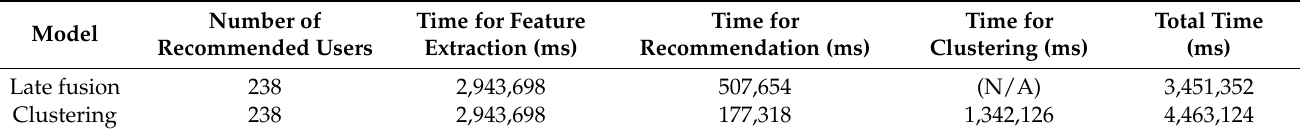
Table 2. The comparison of late fusion and user clustering in terms of execution time. N/A, not applicable. Model